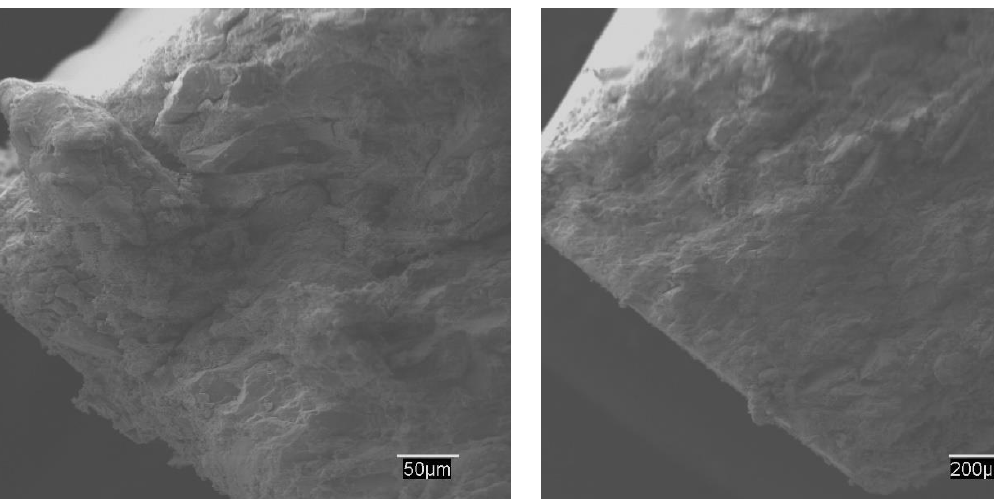
Figure 4. Oral disintegrating tablet (ODT) formula n°14 (150 mg) cross-section 50 µm resolution SEM image, ODT formula n°14 (50 mg) cross-section 200 µm resolution, ODT formula n°15 (200 mg) cross-section 50 µm resolution, ODT formula n° 15 (200 mg) cross-section 200 µm resolution. Change last figures 50 and 200 µm.